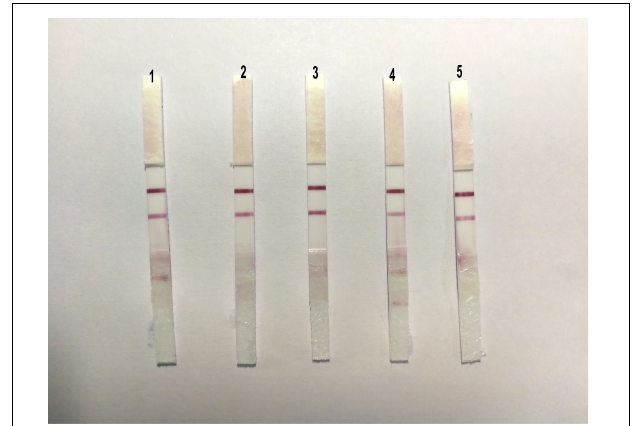
FIGURE 6 | The sensibility of the ICS. The same strain positive allantoic fluid of DTMUV was detected by five different batches of ICS, and there were no obvious differences among the five batches of ICS.